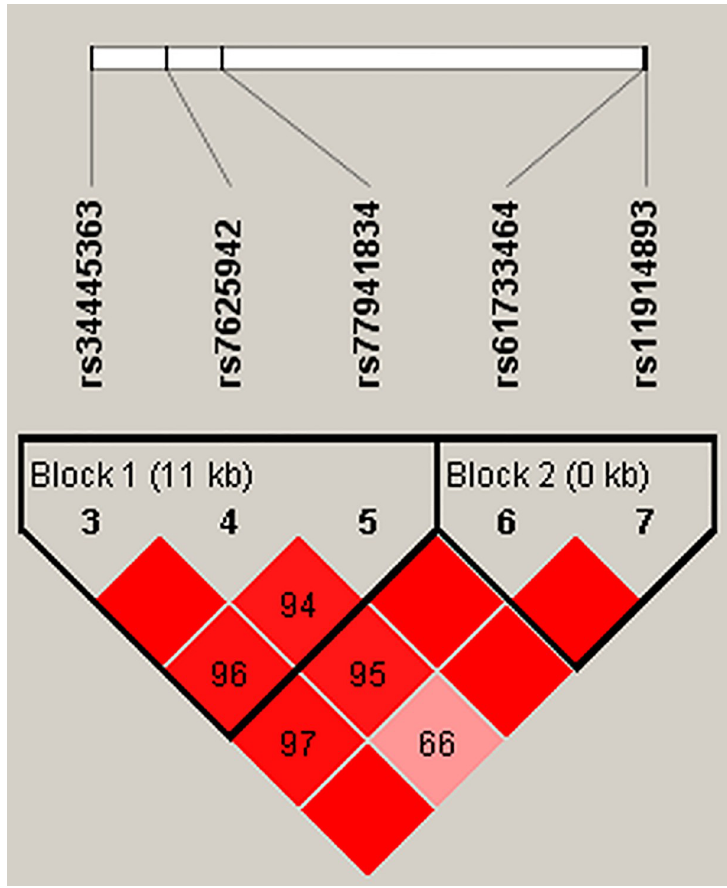
Fig 1. Haplotype block map for SNPs of the COL6A4P2 gene. Linkage disequilibrium plots containing 5 SNPs from COL6A4P2 . Red squares display statistically significant associations between a pair of SNPs, as measured by D’; darker shades of red indicate a higher D’.